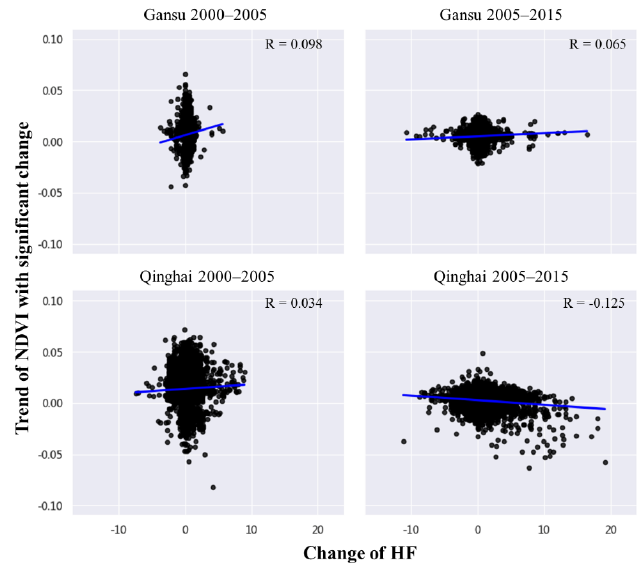
Figure 7. Relationships between significant NDVI trends and changes in the HF for 2000–2005 and 2005–2015 in Gansu and Qinghai. The blue lines show the linear regression results.